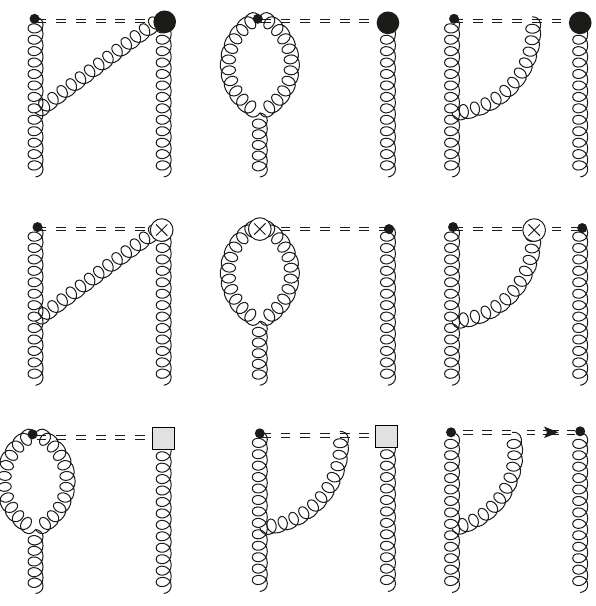
Figure 3 . Upper row: D 0 contribution to eq. (B.30). Middle row: counterterms to the operator i O 3 g (B.20). Lower row: sum of the diagrams in the upper and the middle rows. The shaded box stands for the ( n (cid:22) n ) A (cid:22) (cid:0) (cid:22) n (cid:22) A + vertex and the arrow for ( z 2 (cid:0) w )( n (cid:22) n